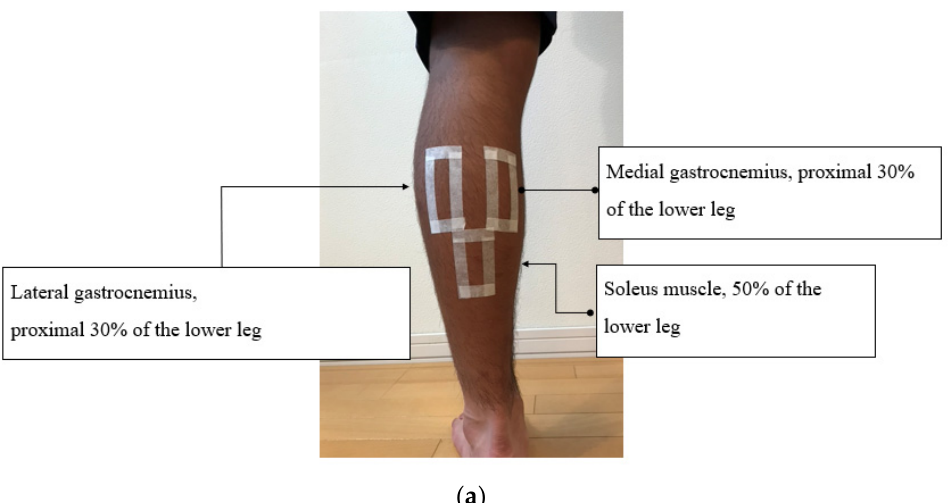
Figure 2. Experimental design, time point for data acquisition. Permission with Plos One 2021 [21].